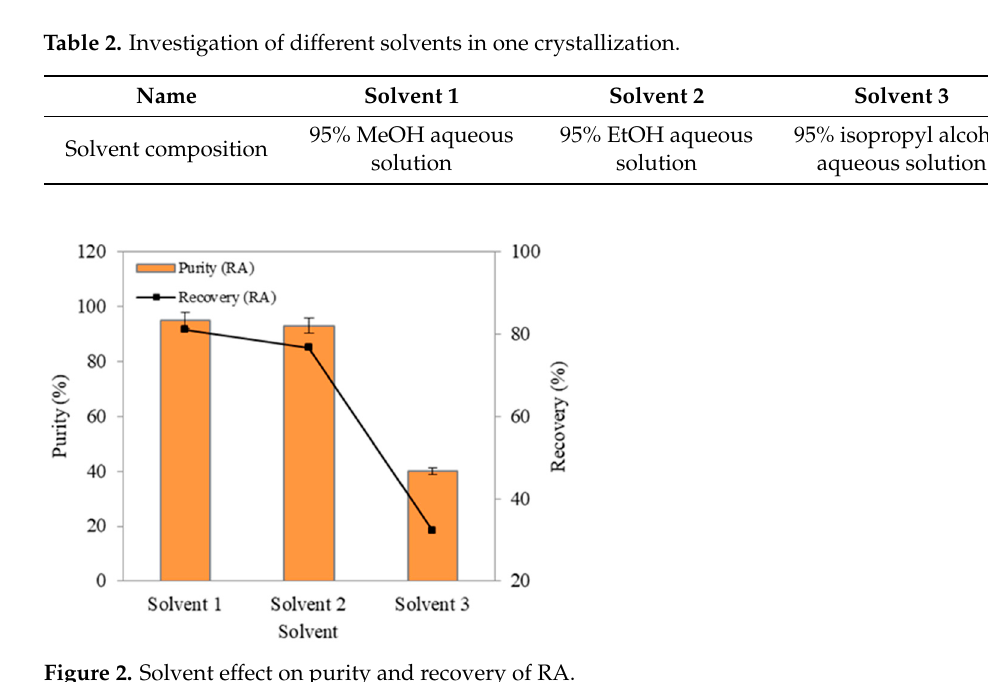
Table 2. Investigation of different solvents in one crystallization.